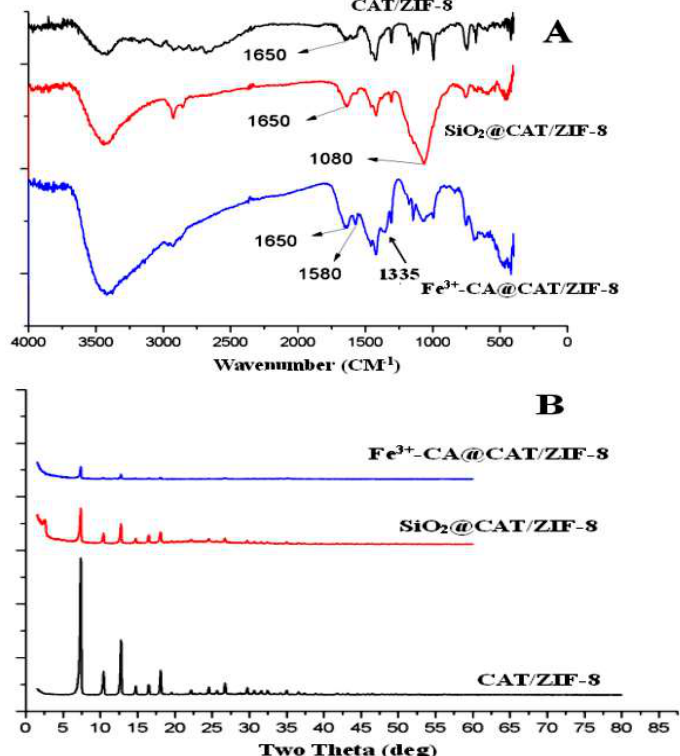
Figure 4. FTIR spectra ( A ) and powder X-ray diffraction (PXRD) pattern ( B ) of CAT/ZIF-8, SiO 2 @CAT/ZIF-8, and Fe 3+ -CA@CAT/ZIF-8.